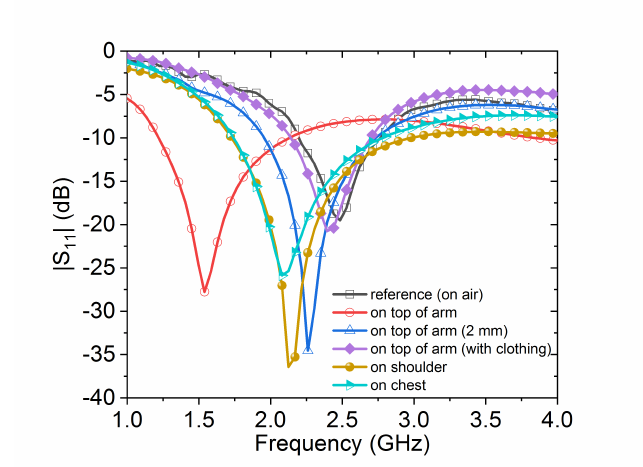
Figure 27. Measuredreflection coefficient for the wearable loop antenna alone when installed on various positions of a male